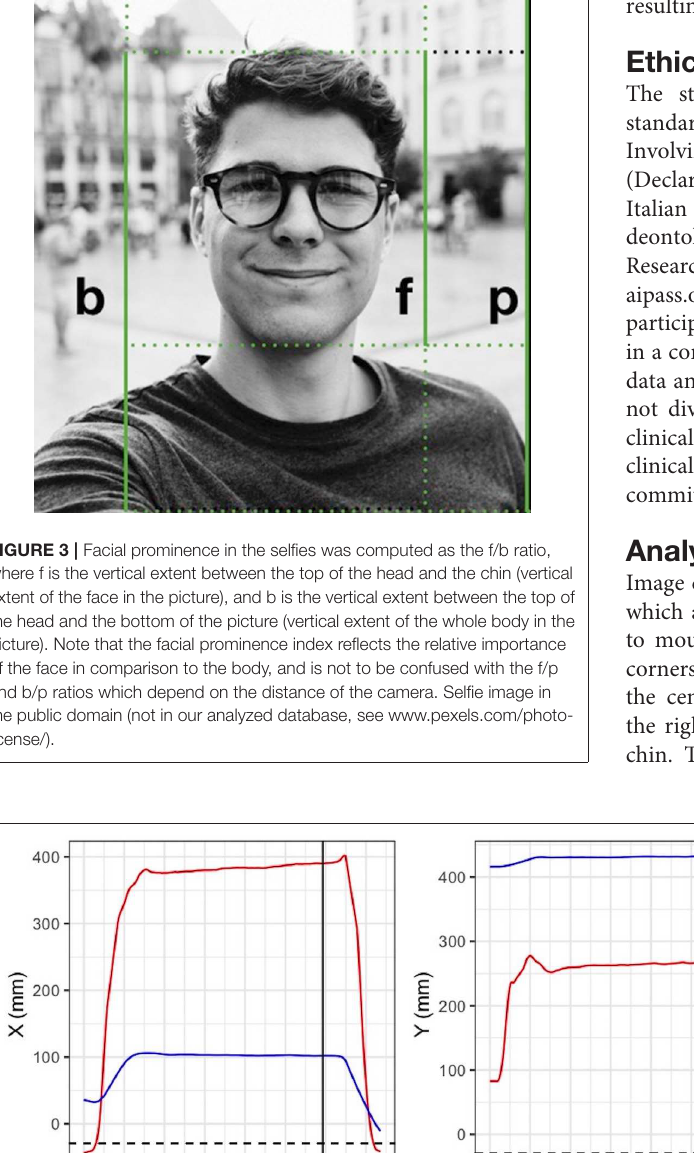
Frontiers in Computer Science |